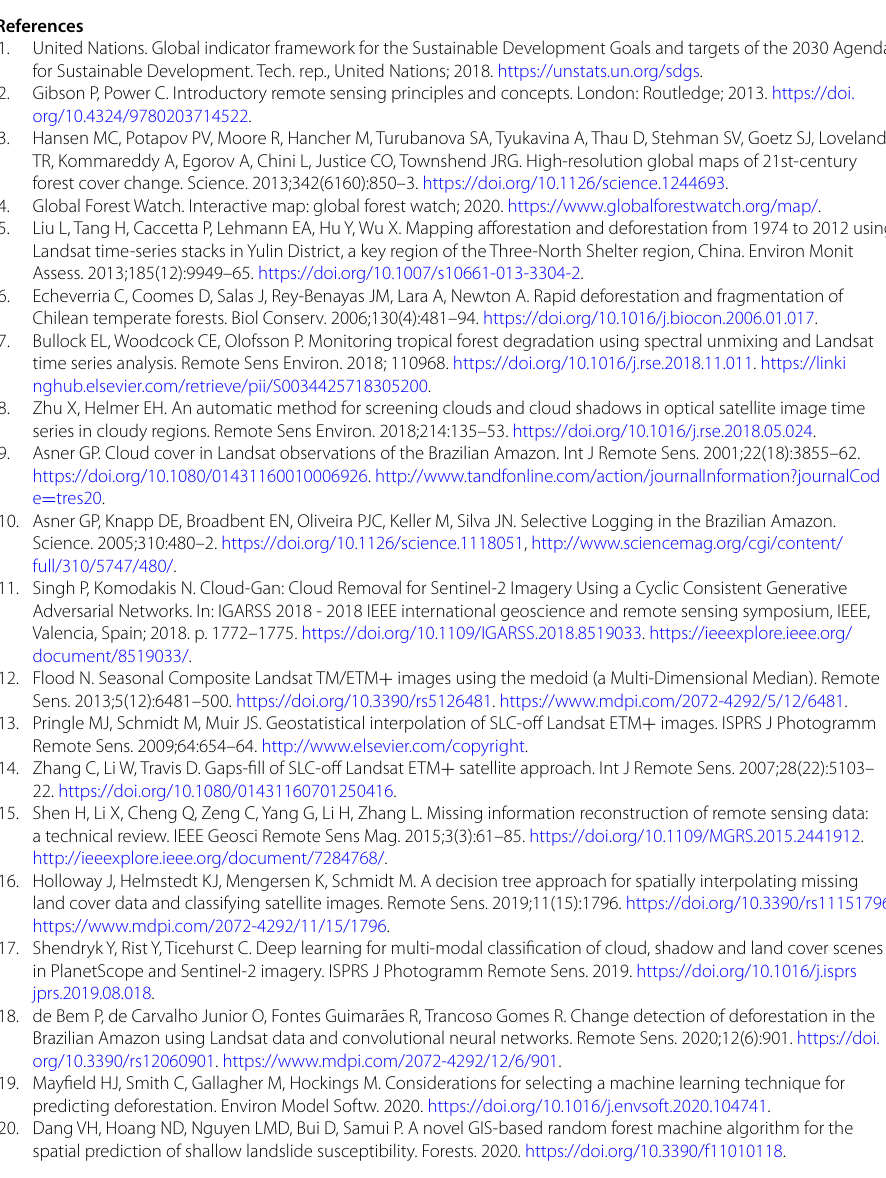
Table 4 Confusion matrix results for input random forest for image 24/07/2017 (t